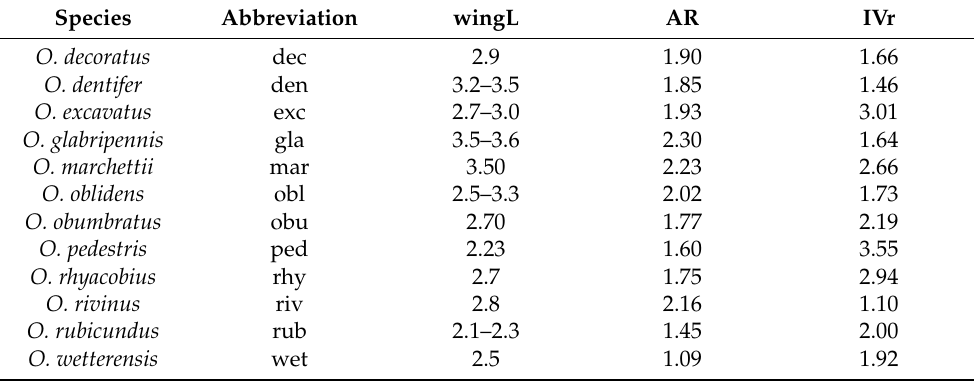
Table 2. Morphometric measures of adult males belonging to different species: wingL: wing length, AR: antennal ratio of adult male, IVr: ratio between length and width of dorsal lobe of inferior